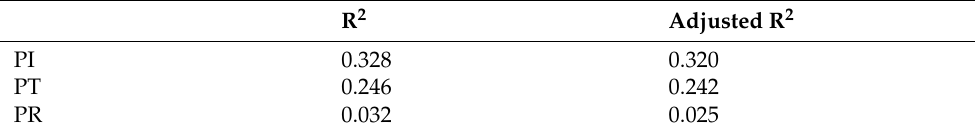
Table 5. Model prediction and goodness of